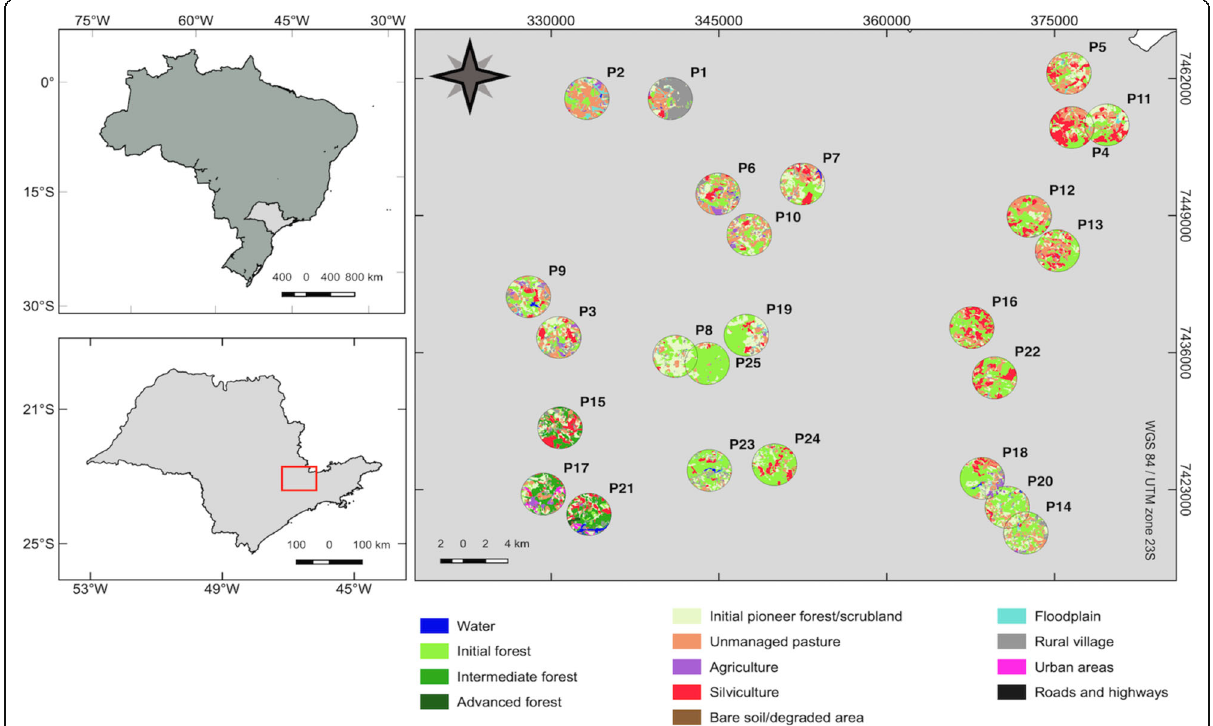
Fig. 1 Study region in southeastern São Paulo, Brazil, showing in detail the 25 sampled landscapes with land cover/land-use classification within a 2-km buffer from each sample point. Landscape numbers ordered by increasing forest cover in 2-km buffers (QGIS Development Team (2002). Open Source Geospatial Foundation Project.